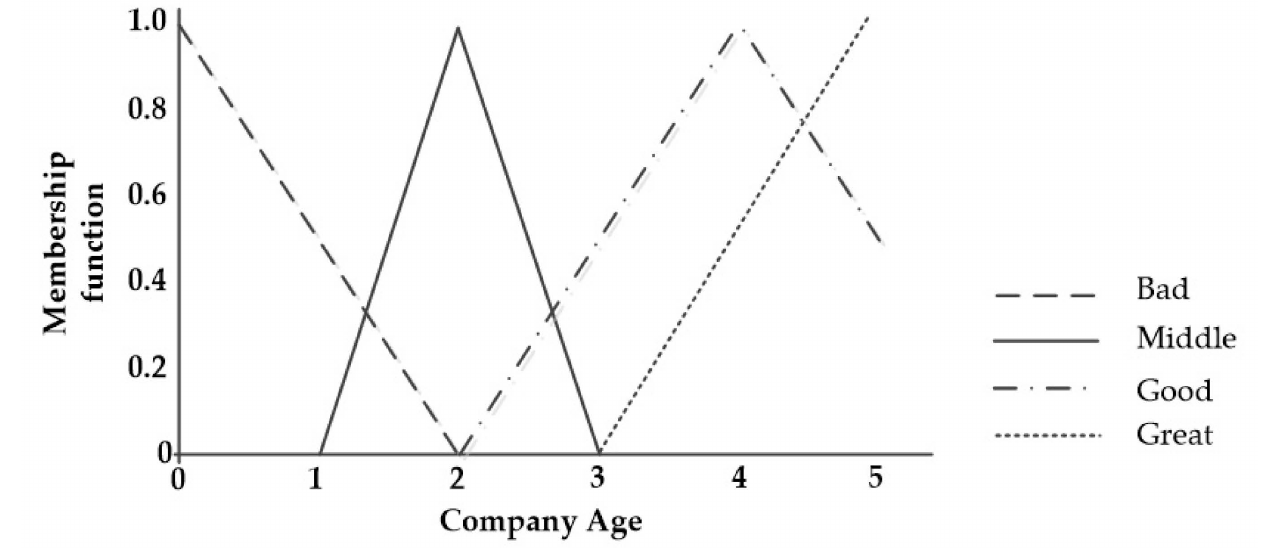
Figure 4. The universe of the function and the distribution of linguistic variables for the parameter “Enterprise